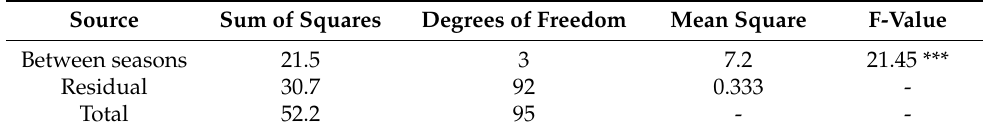
Figure 6. Decomposition of time series of lumber price, including irregular fluctuation indices in Hyrcanian forest in 1992–2015. Table 6. Results of F-test for seasonality in high-value species of lumber price (100 US $ m − 3 ).